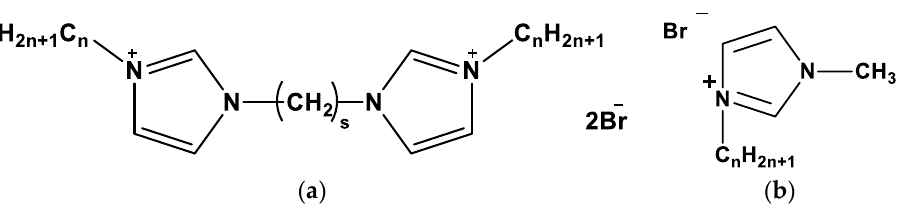
Figure 1. Structural formulas of compounds studied. ( a ) n-s-n (Im), where n = 8, 10, 12, 14, 16, s = 2; 3; 4. ( b ) Im-n, where n = 10, 12, 14, 16,18.